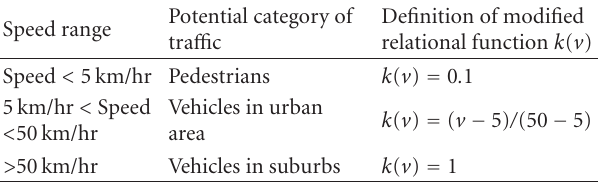
Table 1: Definition of relational function.